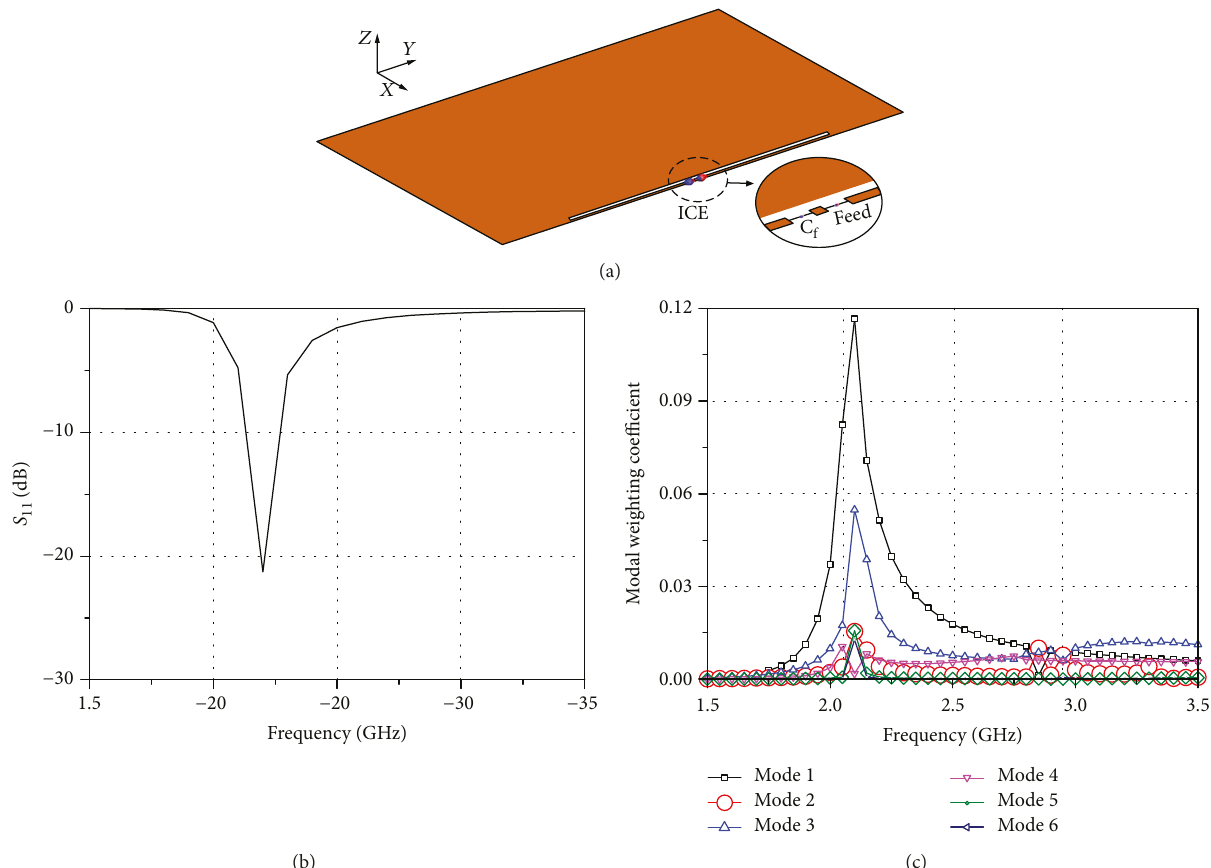
ffi cients: (a) schematic 11 parameter and modal weighting coe